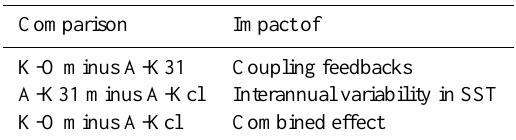
Table 2. Focus comparisons of experiments in the study and the impacts revealed by